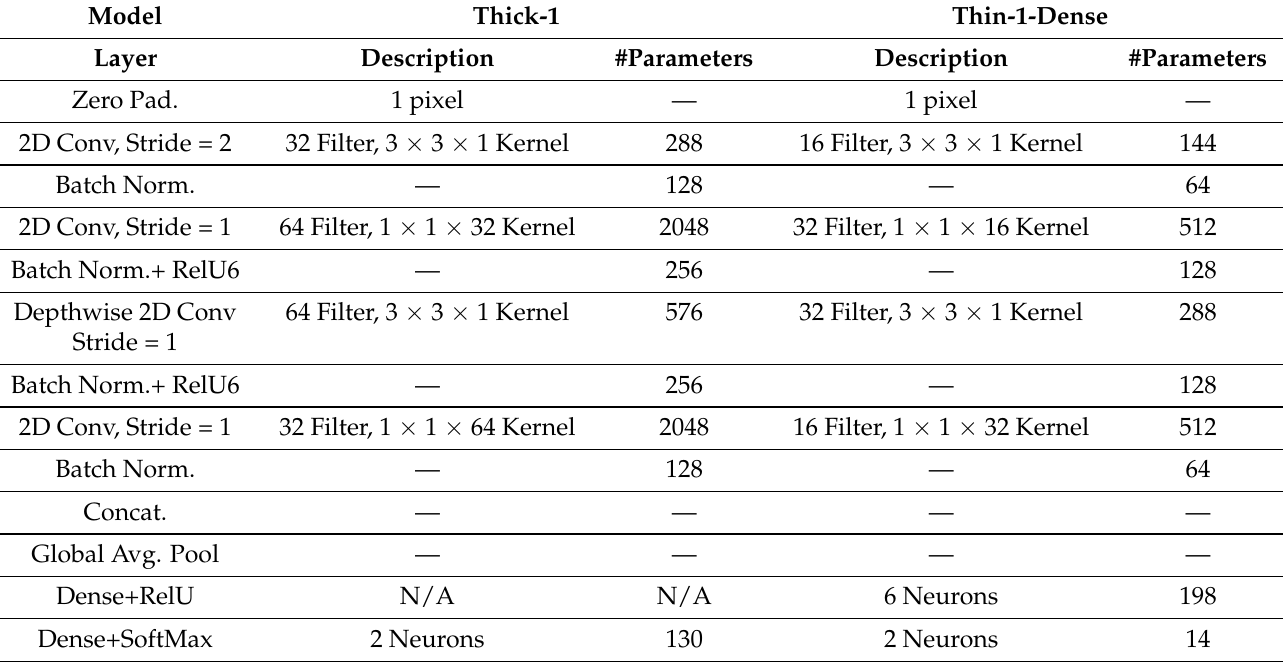
Table A1. Parameters of the Image Classification Unit: models Thick-1 and Thin-1-Dense.